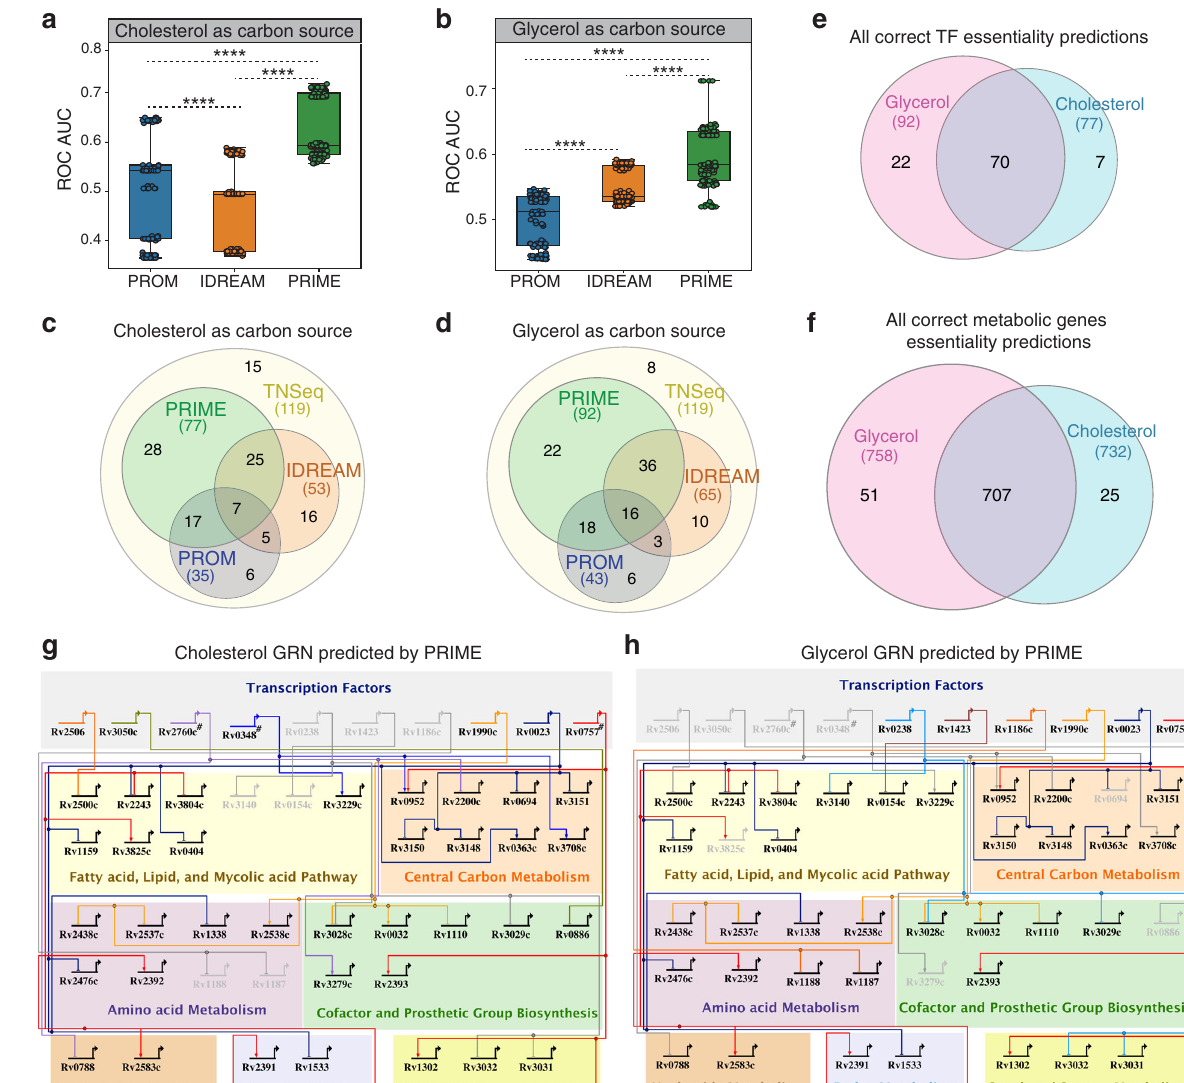
Fig. 3 Validation of PRIME predictions of conditional gene essentiality. Sensitivity and speci fi city of PRIME, PROM, and IDREAM predicted TF essentiality in a . cholesterol and b glycerol as determined by LOOCV analysis for the area under the receiver operating characteristic curve (ROC AUC). All the boxes in the boxplot indicate the upper and lower quartiles of the data and the middle line is the median with the whiskers extending to 1.5× interquartile range. Statistical signi fi cance was calculated as p -value with two sample t -test. **** p -value < 0.0001. Comparison of all positive predictions (true positives and true negatives) for TF essentiality by PRIME, PROM, and IDREAM in c cholesterol and d glycerol. e The number of all correct PRIME predictions (true positives and true negatives) of TF knockouts across the two conditions (glycerol and cholesterol) that are validated by experimental TnSeq data. f The number of all correct PRIME predictions for deletion of all genes in the metabolic network across the two conditions that are validated by experimental TnSeq data. BioTapestry visualization showing a subset of the gene regulatory network of Mtb under growth in g cholesterol and h glycerol. TFs are grouped together in the top panel (represented by bent arrows), which extend to horizontal and vertical lines that connect to their regulatory gene targets. Highlighted TFs were predicted by the PRIME model to be essential and validated through TnSeq dataset in relevant essential metabolic reactions to manifest at a phenotypic level supporting growth in the presence of INH, and compared these (Fig. 4c). Notably, PRIME accurately predicted that knocking out ranks to TnSeq determined importance of TFs. There was striking the top ten TFs one-at-a-time would result in at least 65% and up correlation (Spearman ’ s rho = 0.695; p -value = 0.0001) in the rank to 95% Mtb growth inhibition during INH treatment, but not in the ordering of TFs based on the predicted (PRIME) and observed absence of drug treatment, implicating these as conditional (TnSeq) magnitude of growth inhibition of Mtb in the presence of vulnerabilities for signi fi cantly potentiating INH treatment (Sup- INH upon knocking out each TF one-at-a-time (Supplementary Fig. 9). The correlation increased (Spearman ’ s rho = 0.746, p -value = 0.0001) when only TFs implicated by EGRIN as regulators of the PRIME pathway analysis (PPA) tool to uncover in a single-step essential metabolic reactions were considered in this analysis, the speci fi c metabolic reaction(s) regulated by a TF that make it demonstrating the remarkable accuracy of PRIME in capturing how the differential regulation by TFs modulates fl ux through